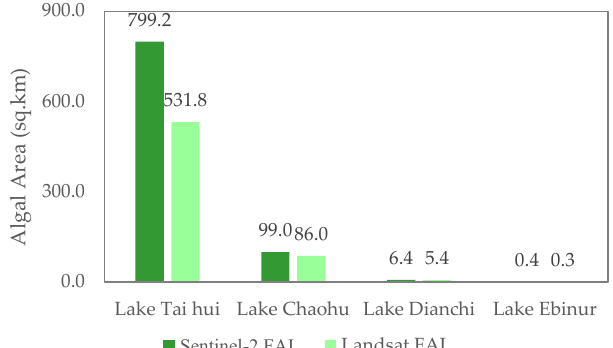
Figure 6. Floating algae area derived by Landsat-8 OLI and Sentinel-2 Figure 6 . Floating algae area derived by Landsat-8 OLI and Sentinel-2 MSI.